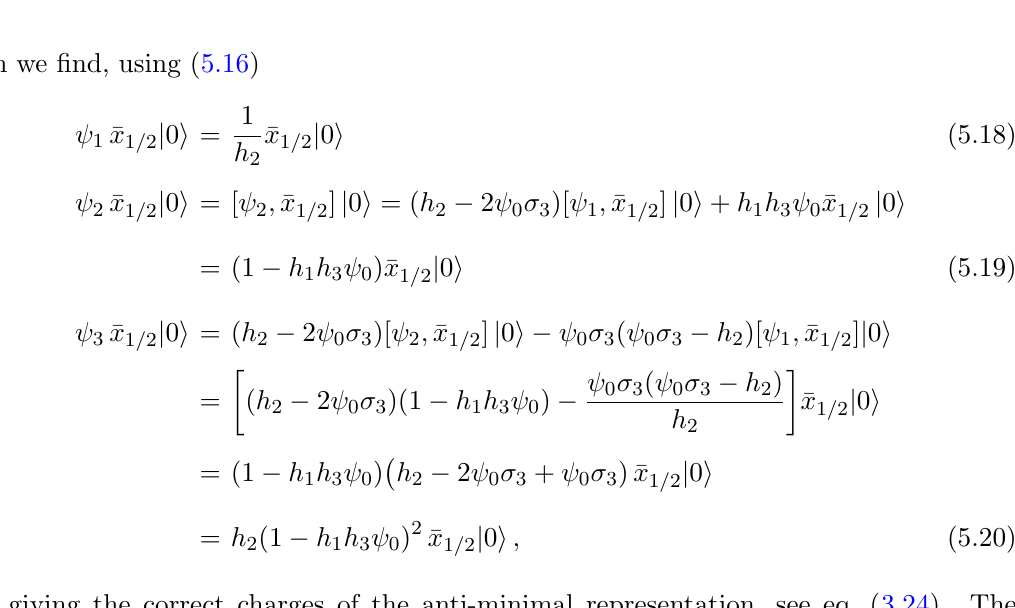
Figure 4 . The additional relations (in red and blue) together with some of the relations from (cid:12)gures 2 and 3 for